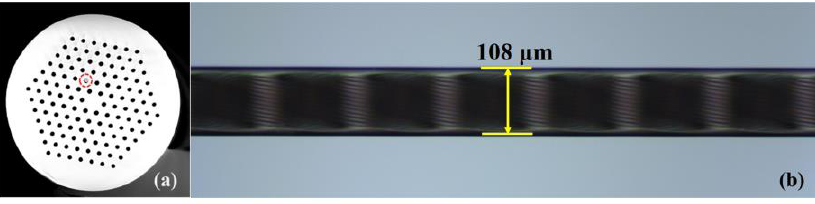
Figure 5. ( a ) Cross-section of the LFTPCF where one hole was filled with a standard refractive index (RI) liquid. The hole was outlined with a red circles. ( b ) Side-view microscope images of the LFTPCFs.